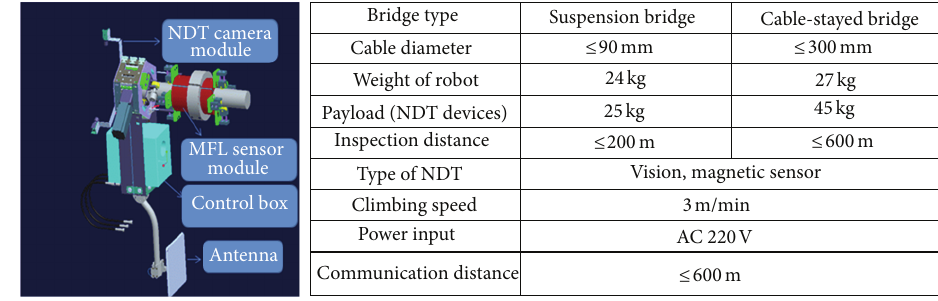
Figure 15: Design and specifications of cable inspection robot unit with the climbing robot subsystem and NDT subsystem.